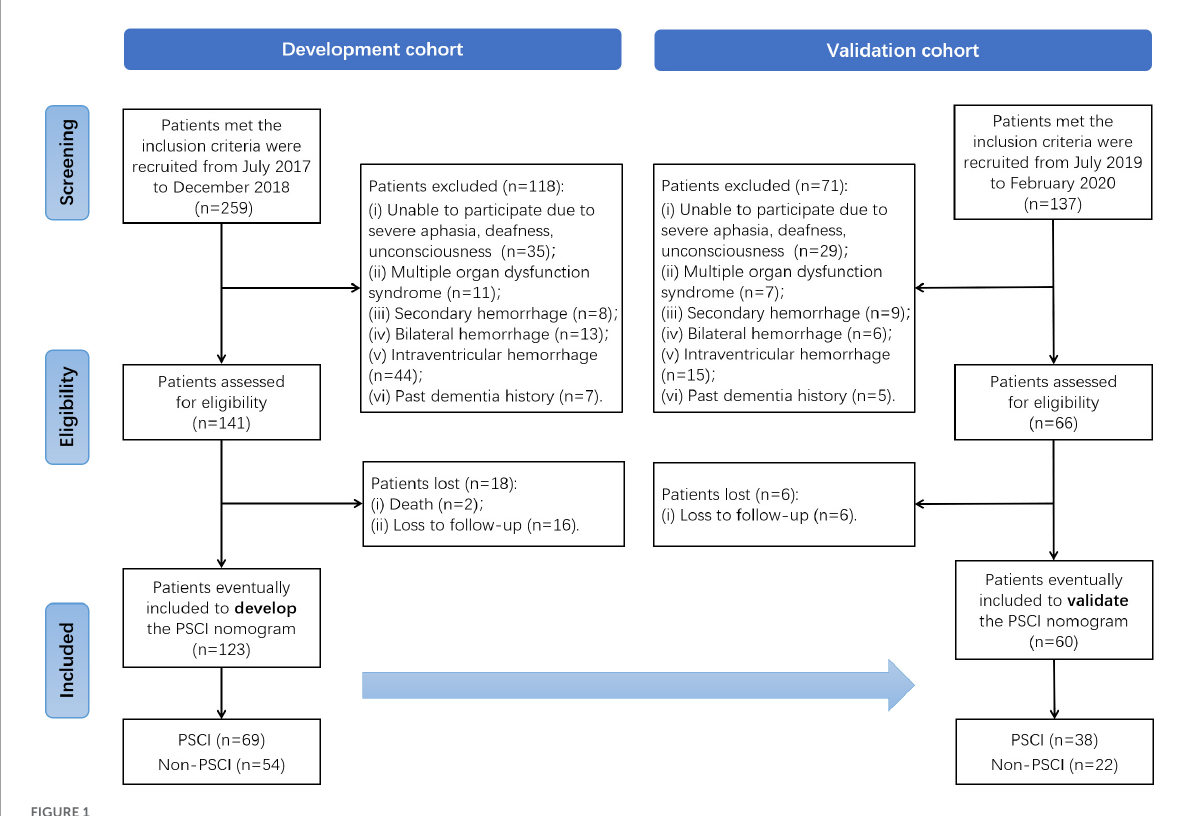
FIGURE1 Flowchart of selection